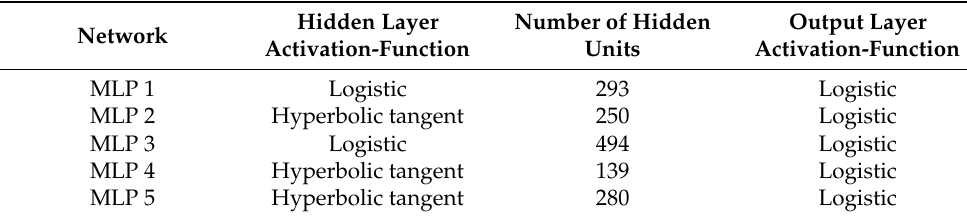
Table 6. Details of the selected MLP models.